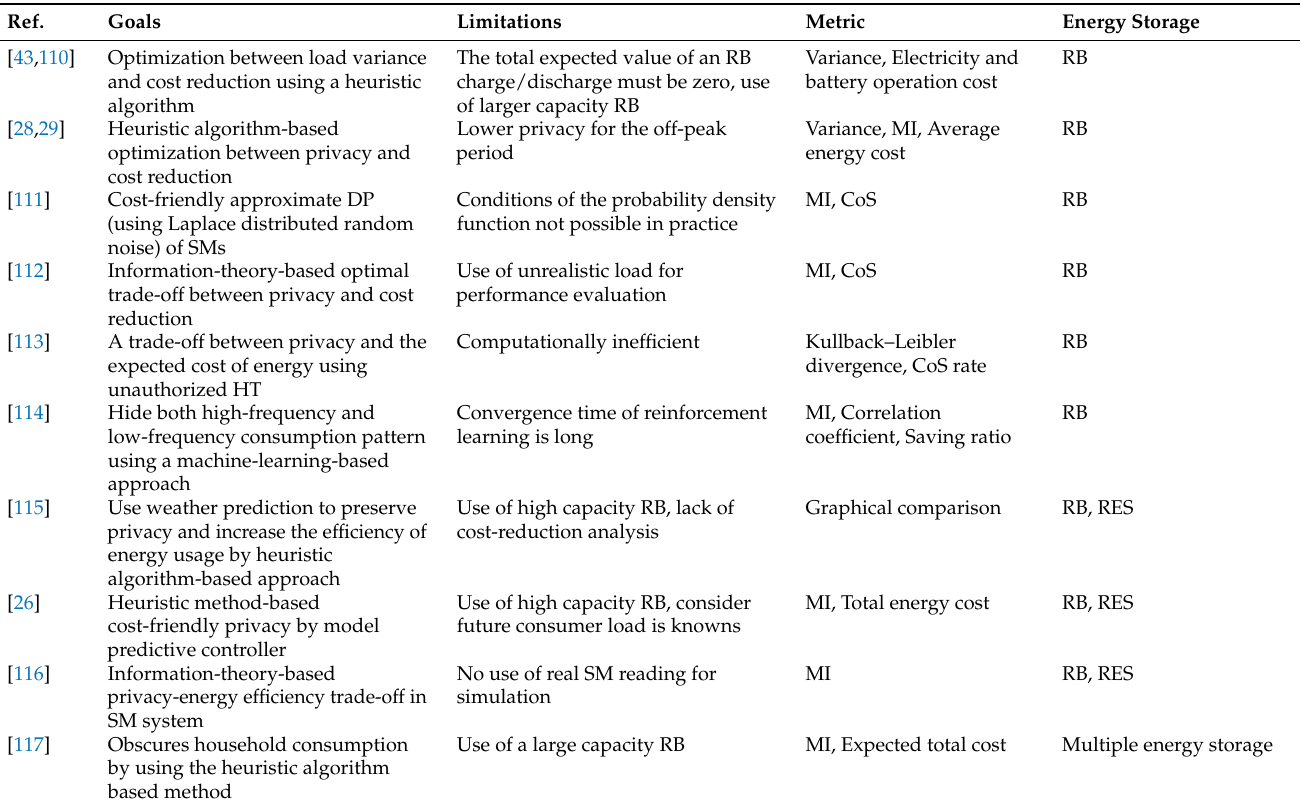
Table 7. Summary of cost-friendly privacy-preservation techniques of SMs against strong adversaries (prioritizing